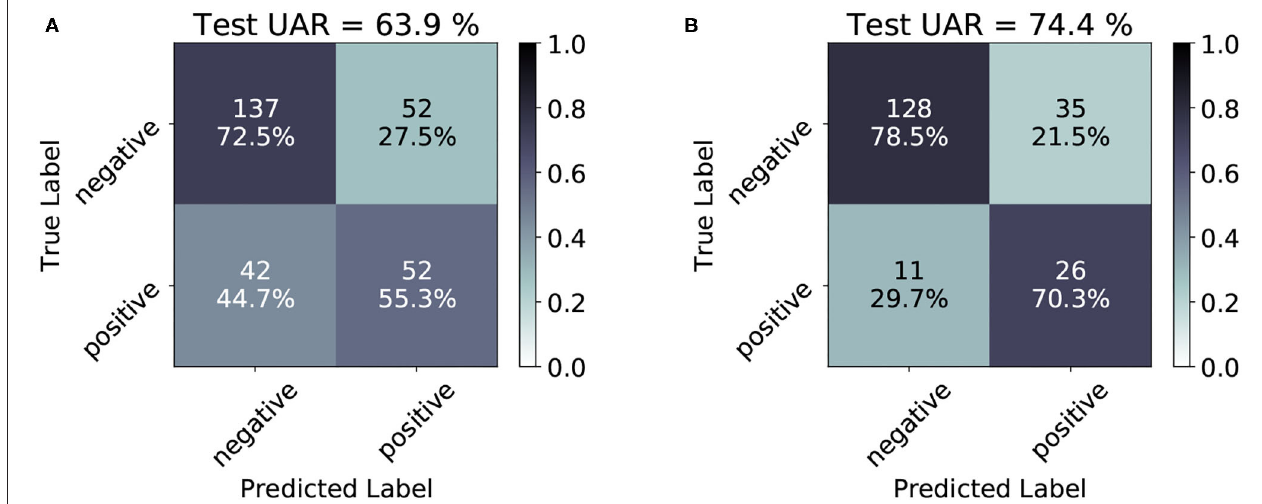
FIGURE 3 | Confusion matrices for the test results obtained by the best CSS (A) and CCS (B) models. In the cells, the absolute number of cases is given, and the percentage of “classified as” of the class is provided in the respective row. The percentage values are also indicated by a color scale: the darker, the higher the prediction. A detailed account of the confusion matrices analysis is given in Section